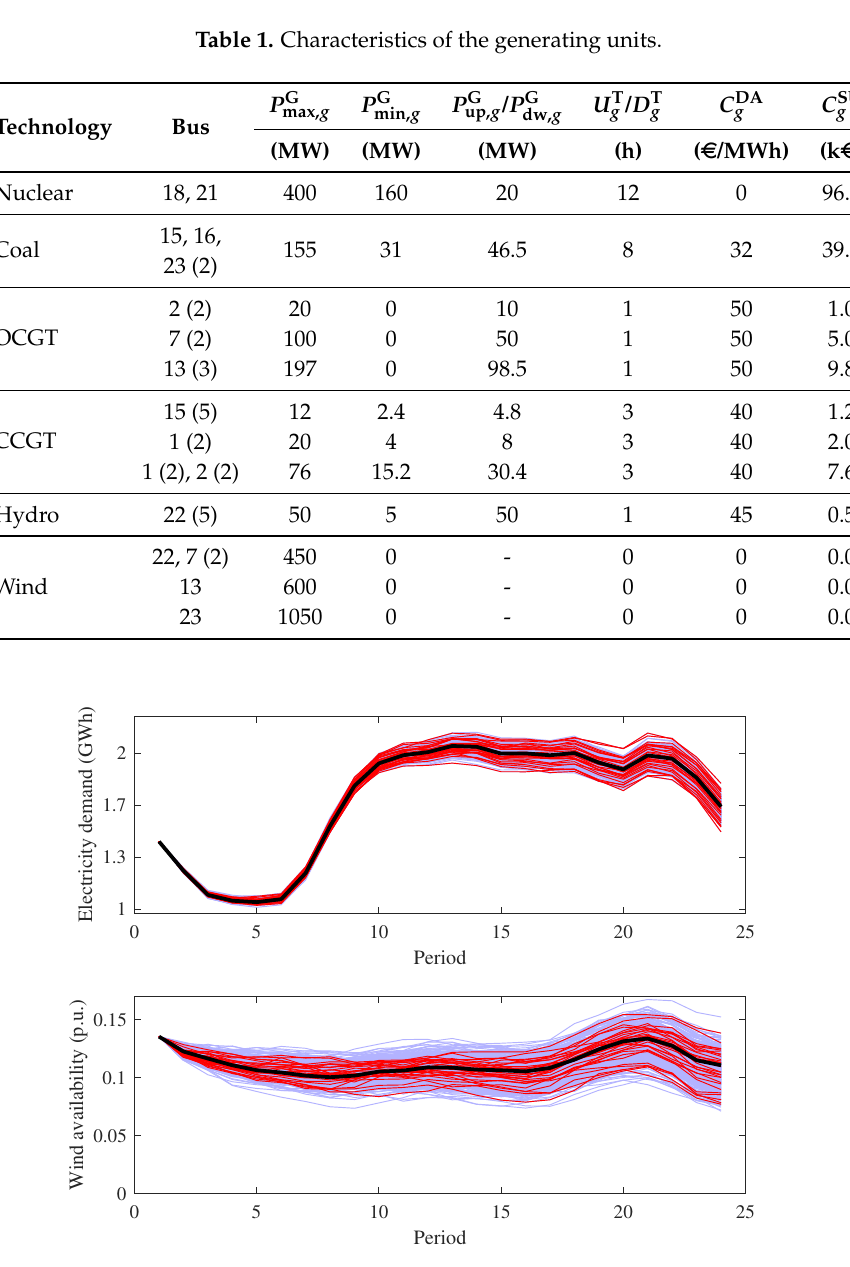
Figure 1. Scenarios for electricity demand and wind